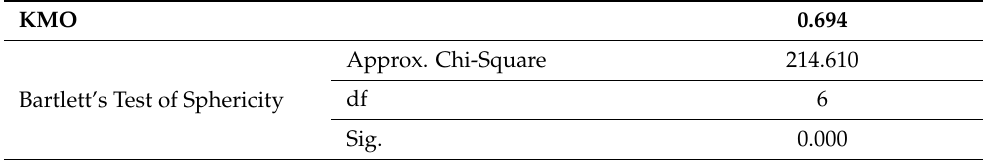
Table 6. KMO and Bartlett’s test (Dependent